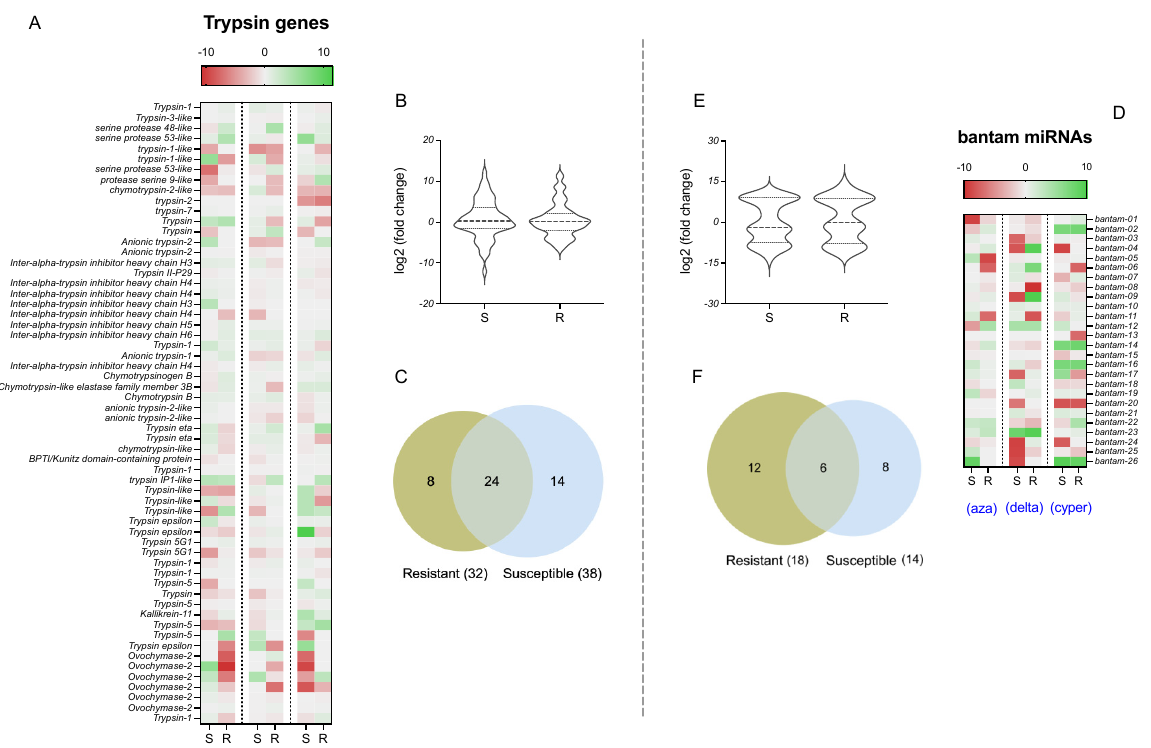
Figure 2. In silico expression analyses for trypsin ( A – C ) and bantam ( D – F ) in C. rogercresseyi exposed to delousing drugs. ( A , D ) Heatmaps for fold change values calculated on exposed samples vs. control for differentially expressed trypsin genes and bantam miRNAs, respectively. Significant expression changes were considered if the fold change > |4| and p - value > 0.01. ( B , E ) Violin plots of the mean expression values of all the differentially expressed trypsin genes and bantam miRNAs, respectively, separated by susceptible and resistant populations to delousing drugs. ( C , F ) Venn diagrams for trypsin genes and bantam miRNAs evaluated in ( B , E ) plots.